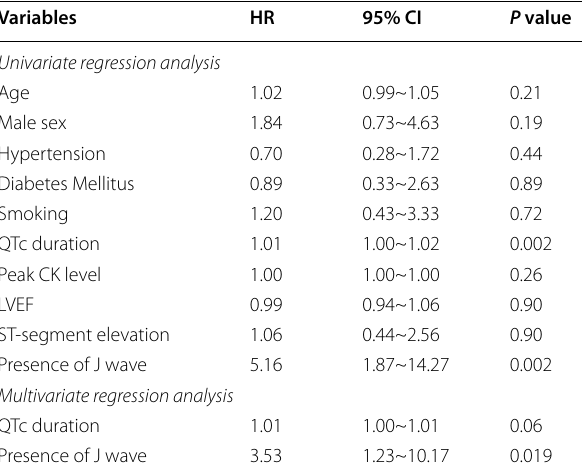
Table 5 Multivariate cox analysis of known risk factors for ventricular